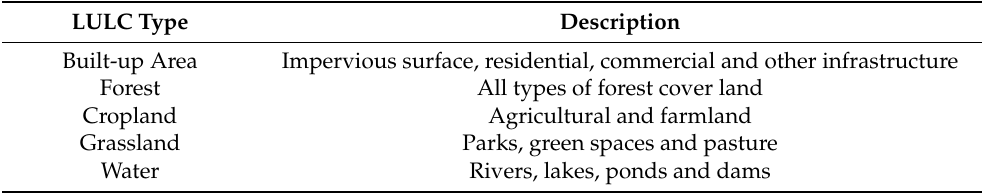
Table 2. LULC classification scheme.